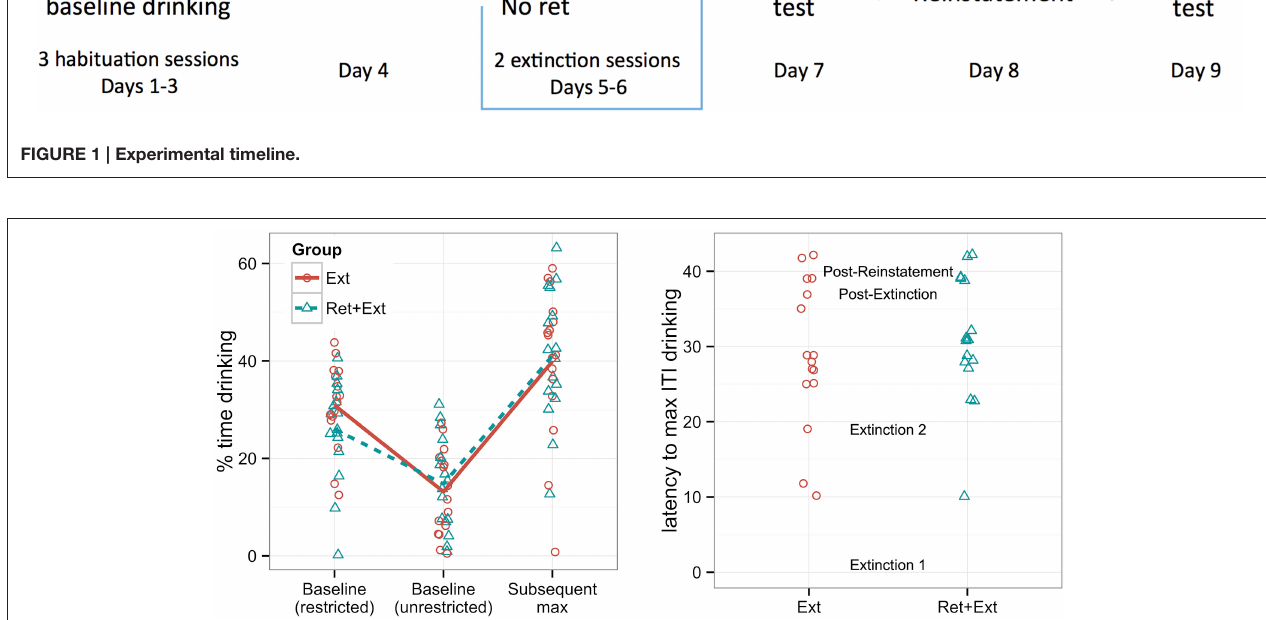
FIGURE 2 | Left panel: Percent time that rats spent drinking a 10% sucrose solution under baseline conditions with and without water restrictions, labeled “Baseline (restricted)” and “Baseline (unrestricted),” respectively, and the maximum ITI drinking reached either during or following extinction, labeled “Subsequent max.” Right panel: The latency (given by the cumulative number of tone-alone presentations across experimental sessions) for each individual to reach its personal maximum ITI drinking (the “Subsequent max” measurement given in the left panel). The session labels in the middle of the graph indicate when each session began with respect to the y-axis. Note that group assignment was not made until after the baseline drinking measures were collected, and groups were explicitly matched for baseline drinking behavior. There were no significant group differences in either the maximum drinking rate or in the latency to reach